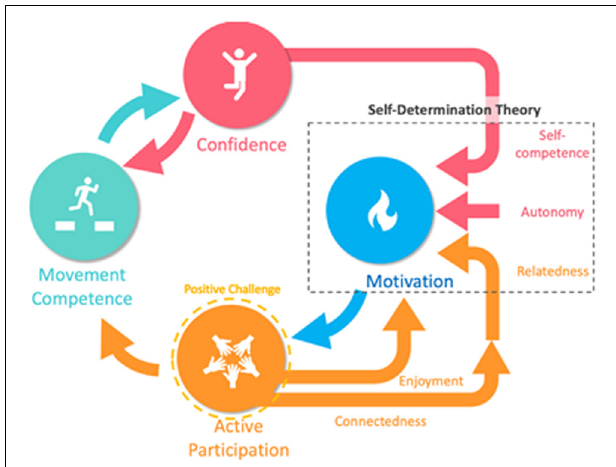
FIGURE 1 | Physical literacy cycle adapted from Cairney et al., 2019 and Jefferies et al., 2019 with self-determination theory